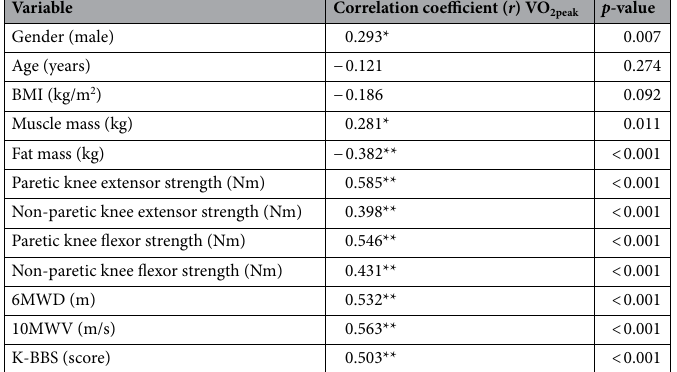
Table 3. Correlation between VO 2peak and body composition, knee muscle strengths, 6MWD, 10MWV, and K-BBS. * p < 0.05, ** p < 0.01. BMI: body mass index, 10MWV: 10-m walk velocity, 6MWD: 6-min walk